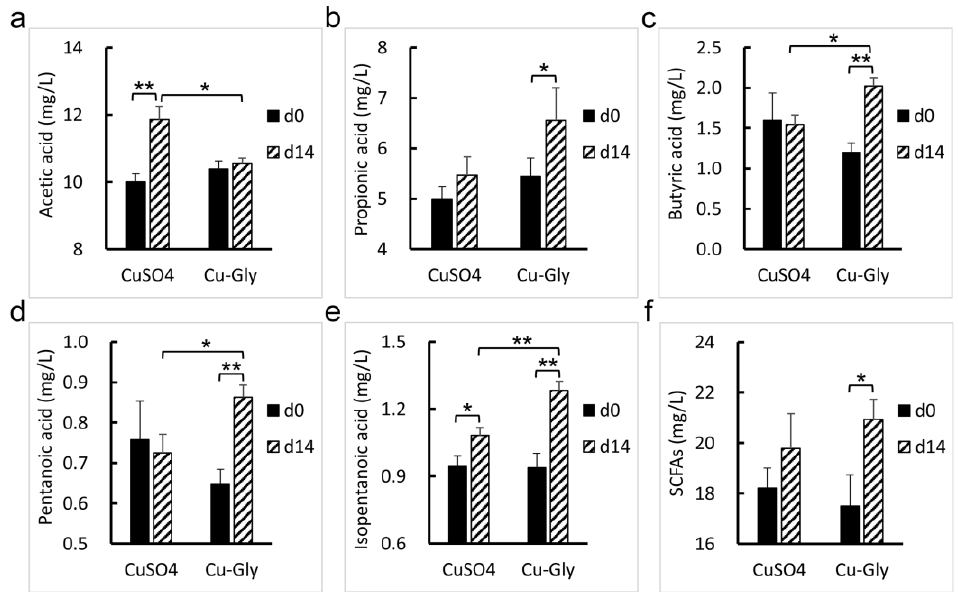
Figure 7. Effects of Cu sources on the concentrations of SCFAs in the feces of pigs. The concentrations of acetic acid ( a ), propionic acid ( b ), butyric acid ( c ), pentanoic acid ( d ), isopentanoic acid ( e ), and SCFAs ( f ) were determined. Data present mean values ± standard errors. * represents a significant difference at p < 0.05, and ** represents a significant difference at p < 0.01. n = 6. SCFAs, short-chain fatty acids.